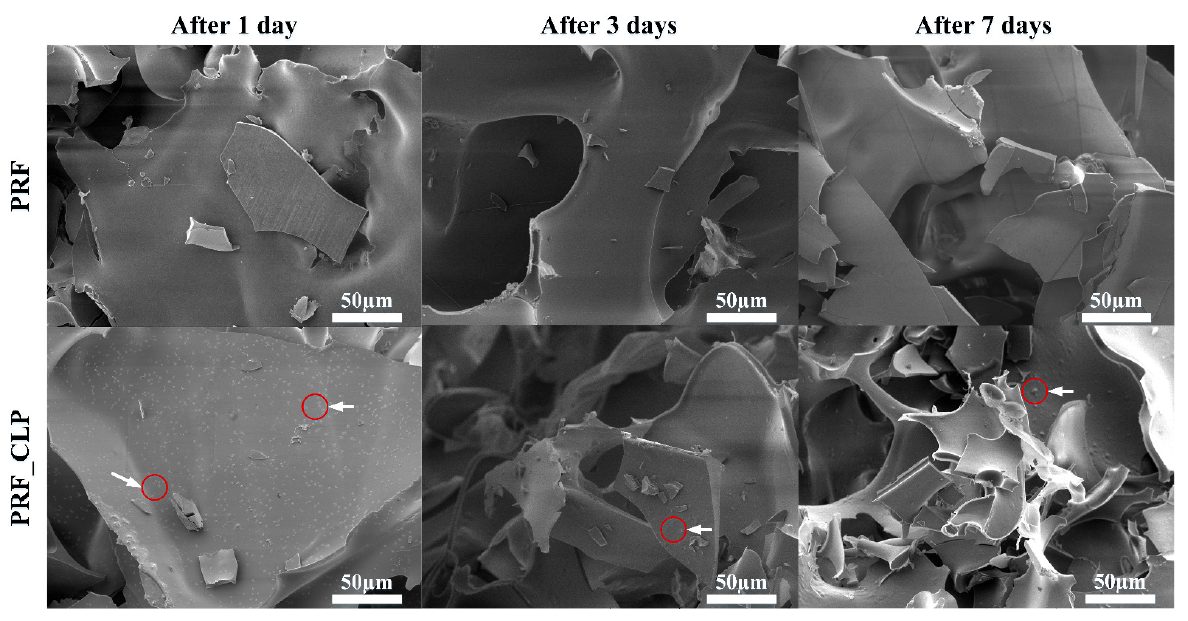
Figure 3. SEM pictures of PRF and PRF_CLP matrix surface; red circles with white arrows indicate the existence of NaCl in the PRF samples.